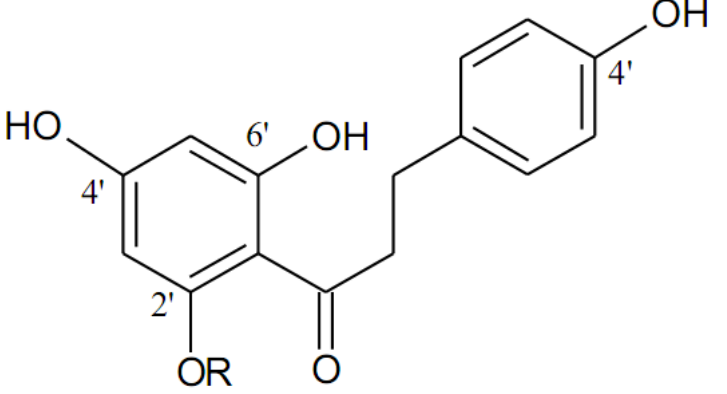
Figure 1. Chemical structures of phloretin (R=H) and phloridzin (R= D